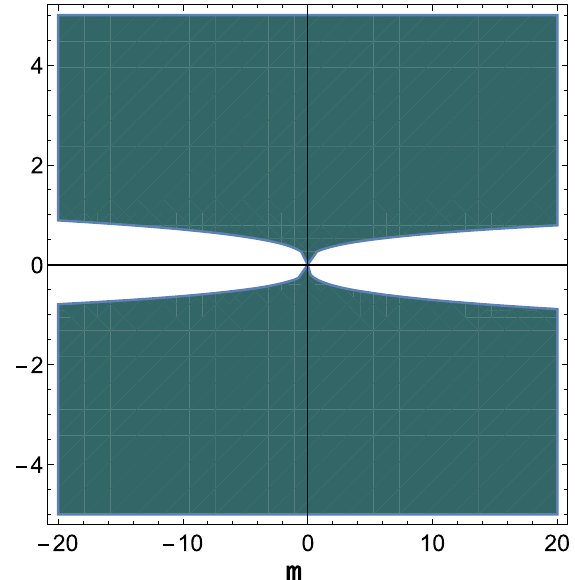
Fig. 10 A non-exclusive possible region where the F critical have a spiral behavior due to the imaginary values of the corresponding